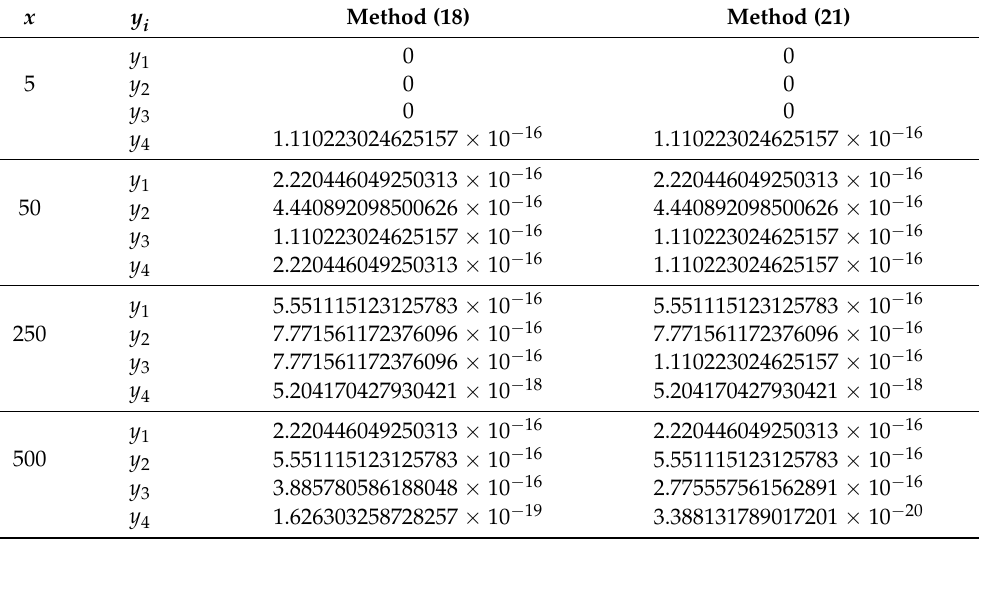
Table 4. Absolute errors in the numerical integration of Example 3.